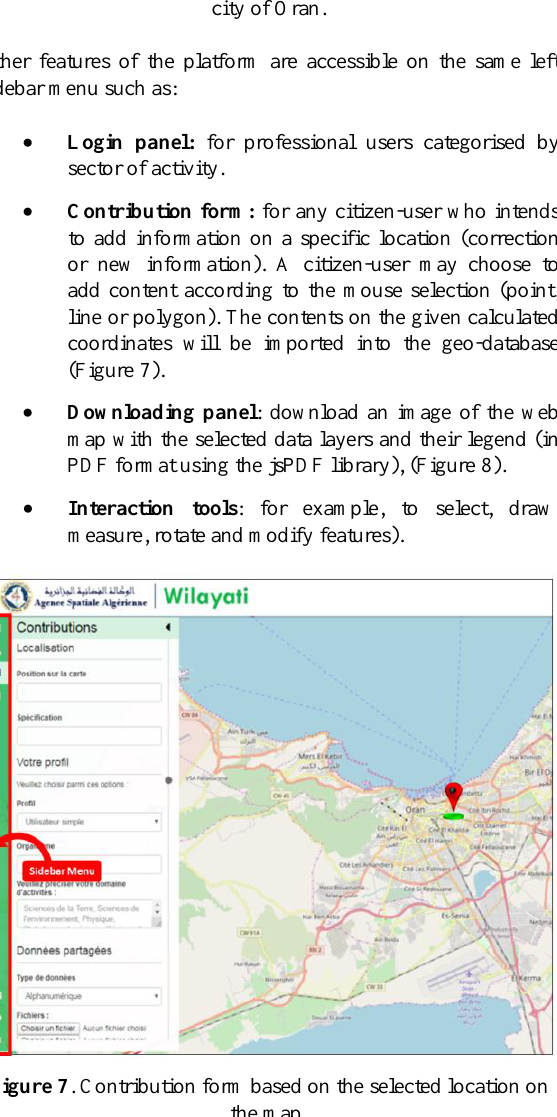
Figure 8 . Download form based on the map